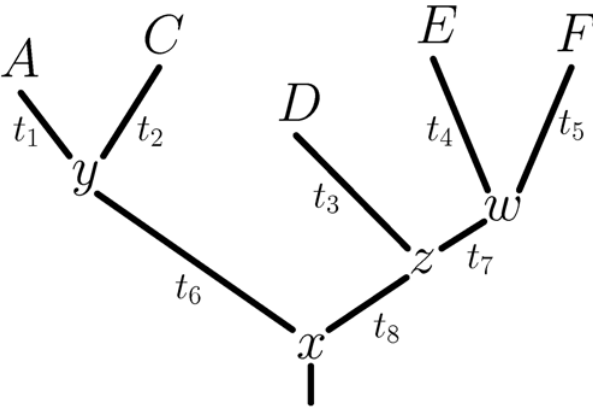
Figure 3. An example phylogenetic tree T . This tree shows the sequence data S r ð Þ for five sequences at a single site r . The amino acid codes at the tips of the branches ( A , C , D , E , and F ) show the residue identities for the five sequences at this site. The variables at the internal nodes ( x , y , z , w ) are the amino acid identities at the site for the ancestral sequences, and must be inferred. The branch lengths ( t 1 , t 2 , ... )